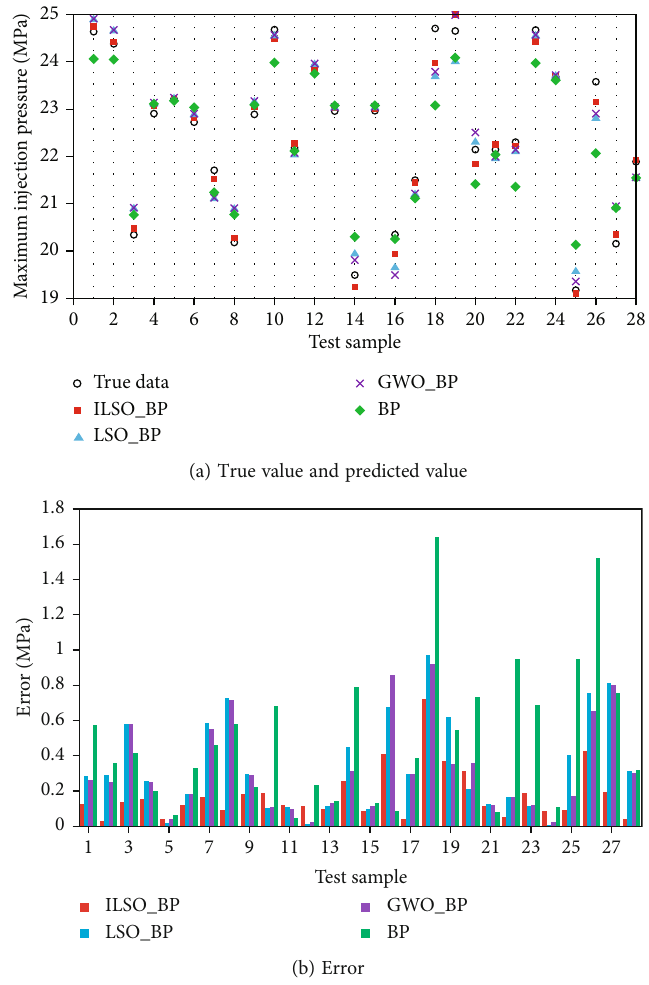
Figure 15: Comparison in test